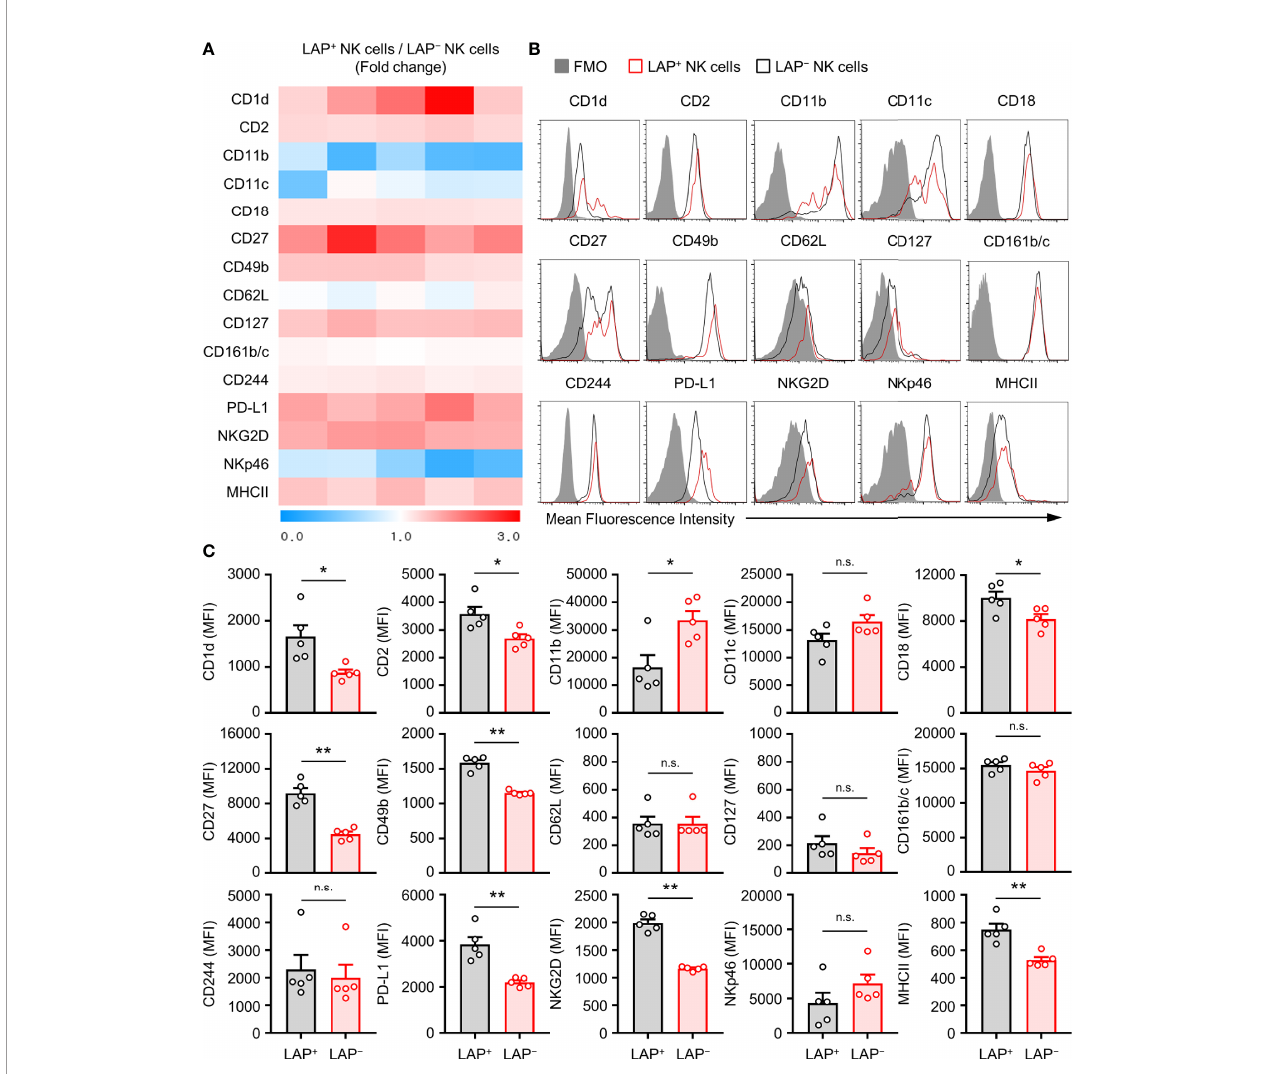
FIGURE 2 | Characterization of TGF- b + NK cells in mouse. (A) Heat map showing fold change of surface protein molecules expression between TGF- b + and TGF- b − splenic NK cells by fl ow cytometric analysis. The ratio values of LAP + /LAP – NK protein mean fl uorescence intensity (MFI) expression for each group were expressed from 0 to 3 folds (n = 5). (B) Representative histogram images for fl ow cytometric analysis of cell surface molecules of TGF- b + and TGF- b − NK cells. (C) Histograms showing the MFI of each surface molecules on NK cells. Results are expressed as representative images and the mean ± SEM from fi ve independent experiments. * p < 0.05; ** p < 0.01; n.s., not signi fi